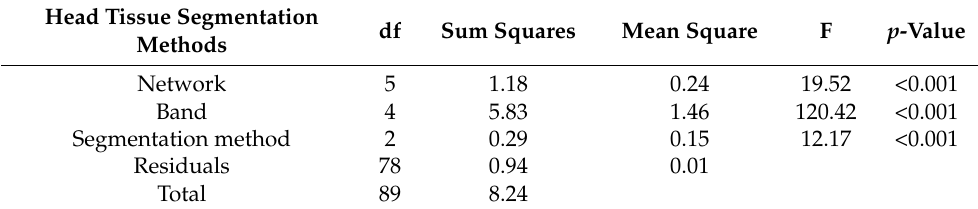
Table 2. ANOVA testing for head tissue segmentation methods. Three factors were assessed: resting- state network (DMN; DAN; VAN; LN; SMN; VN), frequency band (delta; theta; alpha; beta; gamma) and segmentation method ( 12-layer WTS ; 3-layer WTS ; 3-layer template ).